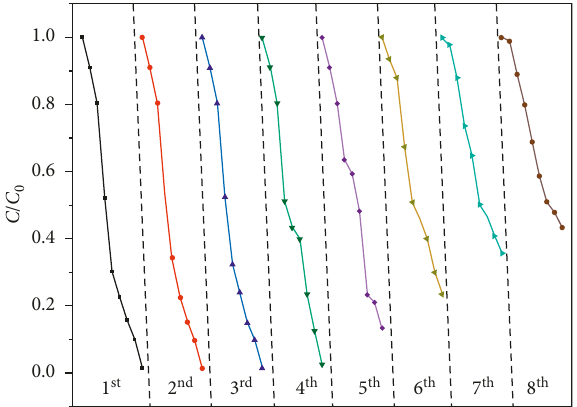
Figure 10: Reusability of the synthesized composite